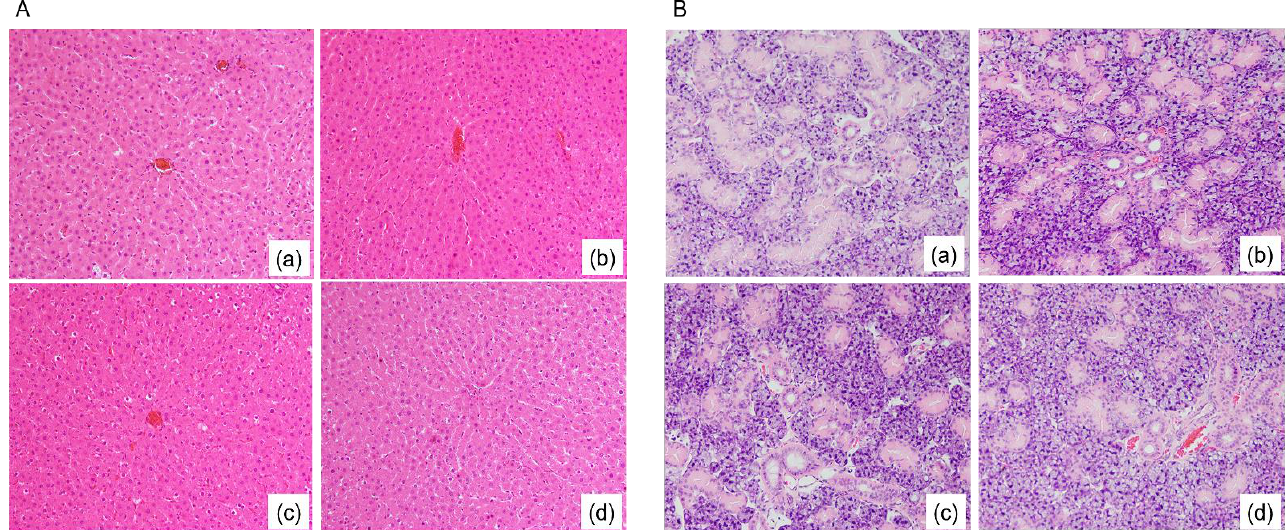
Figure 1. Hematoxylin and eosin staining of liver tissue ( A ) and submandibular gland (SMG) tissue ( B ). The rat groups were fed a low-fat fiberless diet ( a ), low-fat fructo-oligosaccharide diet ( b ), high-fat fiberless diet ( c ), or high-fat fructo- oligosaccharide diet ( d ) for 70 days. Magnification (400×).